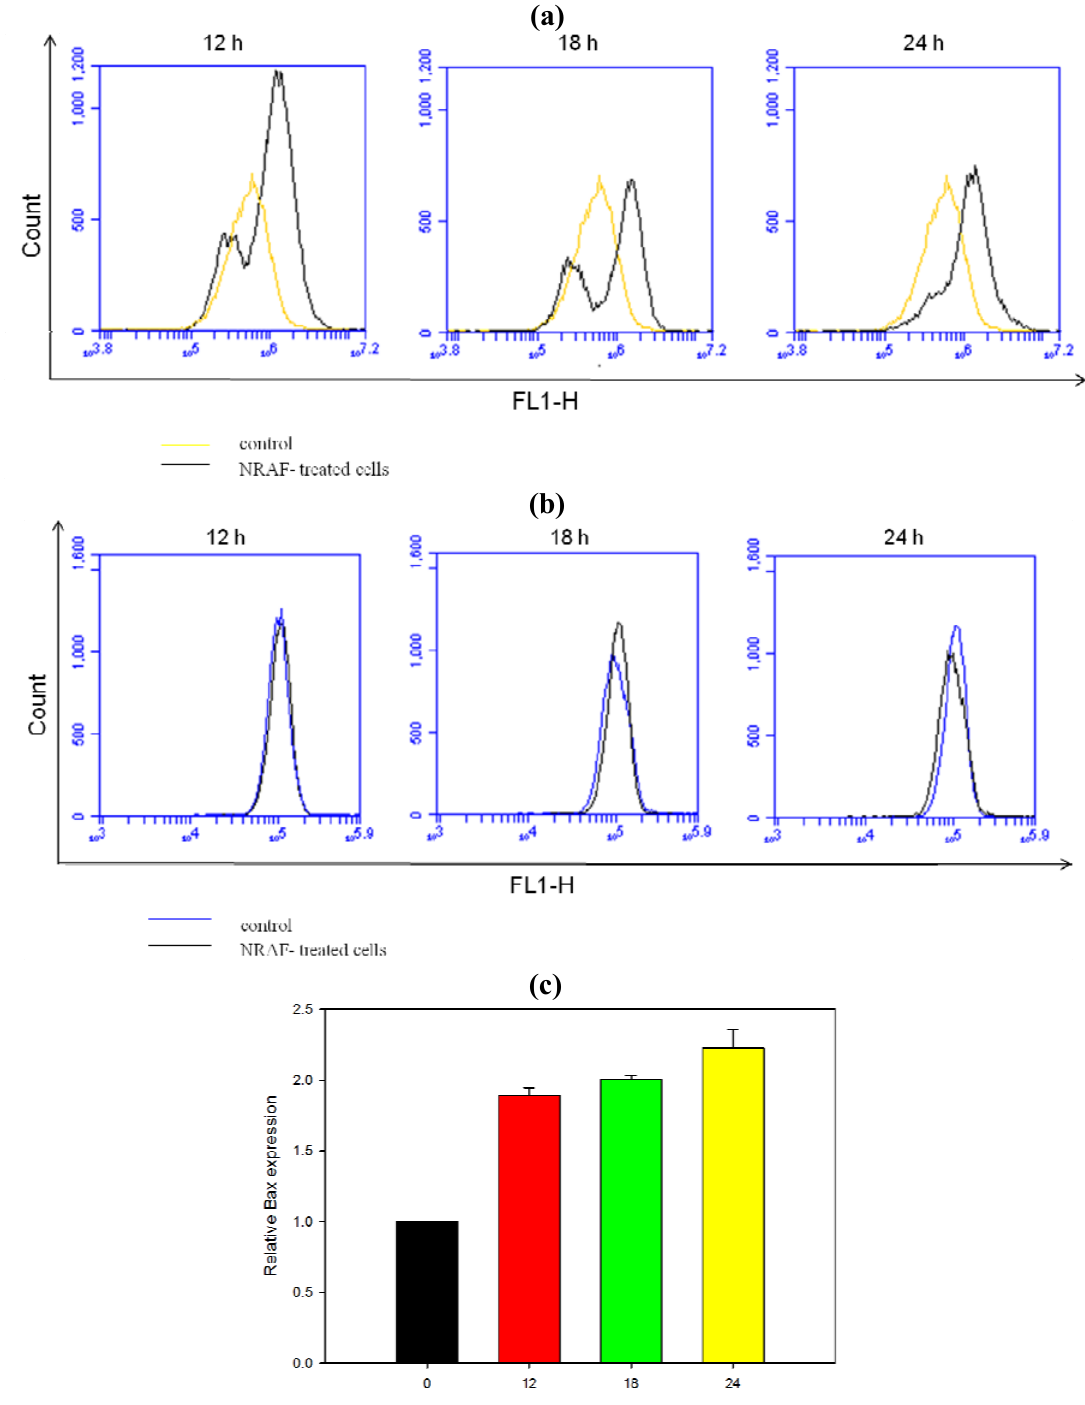
Figure 8. Effect of NRAF on protein expression level of Bax and Bcl-2 in HT-29 cells. Cells were treated with 50 µg/mL of NRAF for different times. ( a ) The histogram showed the expression of Bax in the treated-HT-29 cells at different exposure time. ( b ) The histogram showed the expression of Bcl-2 in the treated-HT-29 cells at different exposure time. ( c ) Bar chart showed the relative Bax protein expression level. ( d ) Bar chart showed the relative Bcl-2 protein expression level. ( e ) Bar chart showed the ratio of Bax/Bcl-2. The data expressed as mean ± S.E. from three individual experiments. Asterisks indicate significantly different value from control (* p <